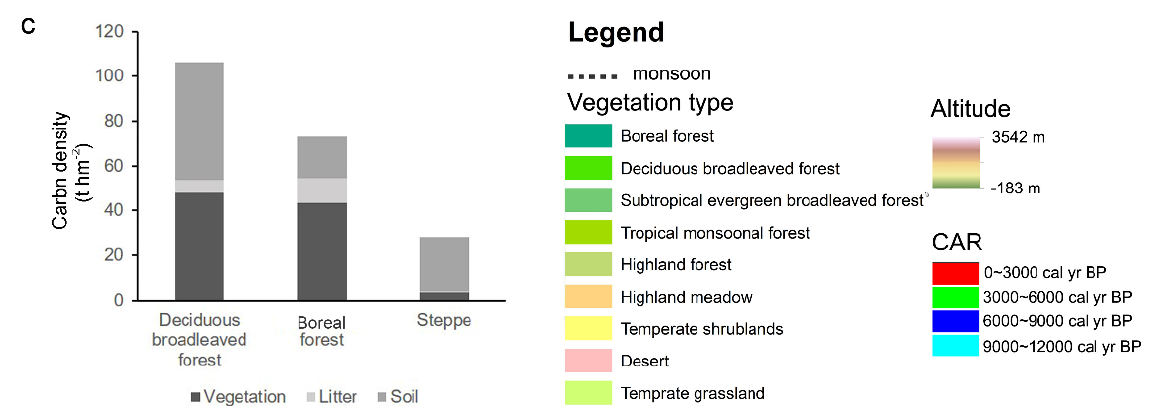
Figure 1. Location of Huangqihai Lake at the regional and local scales. ( a ) Map of China showing the location of the study region, the East Asian Monsoon margin and the location of Huangqihai Lake (HQH), other lakes mentioned (Anguli Nuur, AGLN; Daihai, DH; Qigai Nuur, QG; Yanhaizi Lake, YHZ) and Dongge, Sanbao and Hulu Cave (rectangle area as shown in detail in b ); ( b ) DEM image of the study area showing the Huangqihai Lake and other lakes. The CAR dynamics for these five lakes during the Holocene are shown as a bar chart (g C m − 2 yr − 1 ); ( c ) carbon density of three ecosystem types in the study region [28]. All the legends are shown at the bottom right.